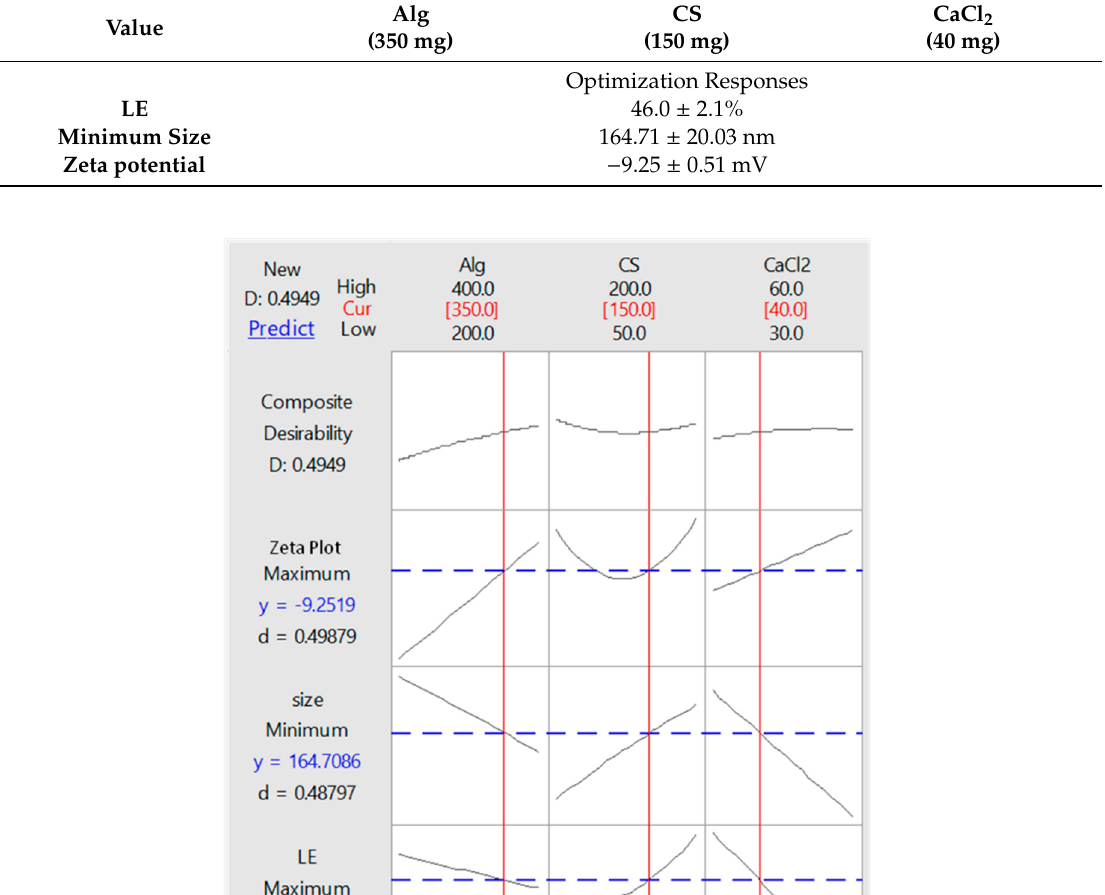
Table 6. Response optimization for LE, particle size and zeta potential. 343